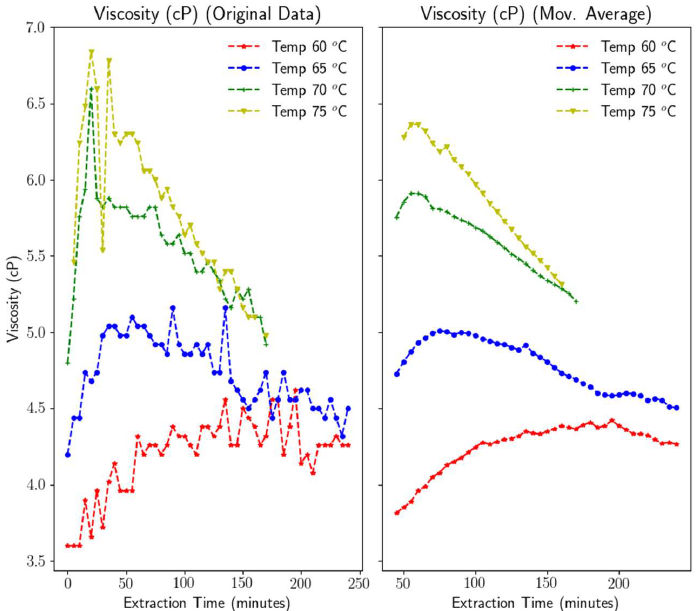
Figure 7. Viscosity cP with different extraction times and at different temperatures.